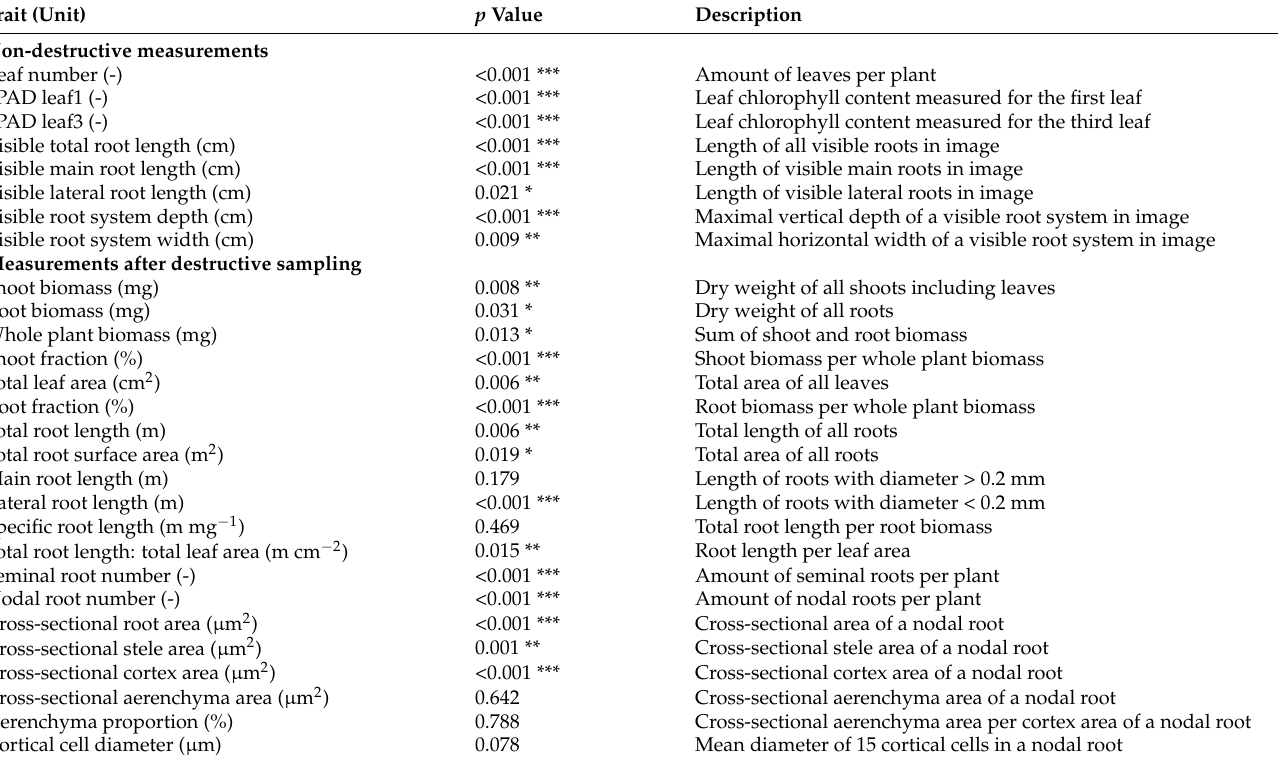
Table 1. Analysis of variance (ANOVA) for genotype effect on various traits measured at day 20 for nine spring wheat genotypes. Trait